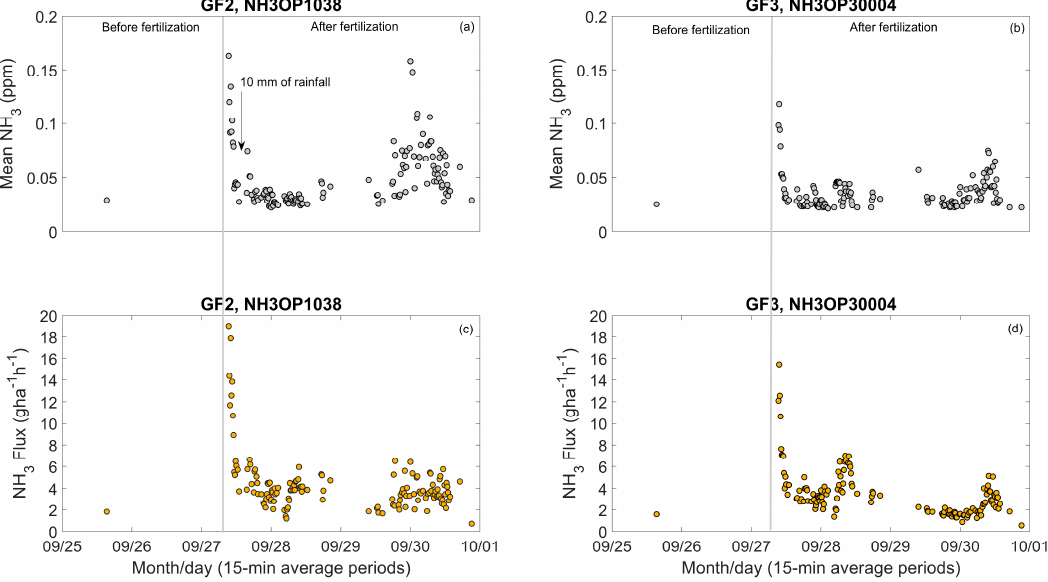
Figure 7. Fifteen-minute averaged NH 3 concentrations ( a, b ) and NH 3 fluxes ( c, d ) after data filtering to remove periods of low wind speed and/or neutral atmospheric conditions for both lasers (GF2, NH3OP1038 and GF3, NH3OP30004).